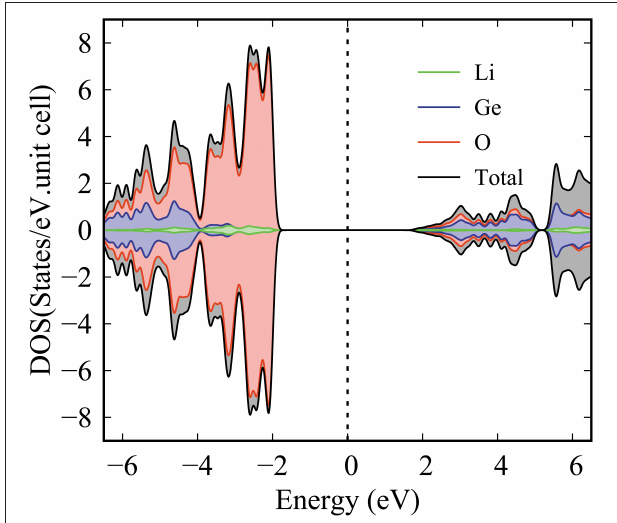
FIGURE 4 | The atom-density of states of Li 2 GeO 3